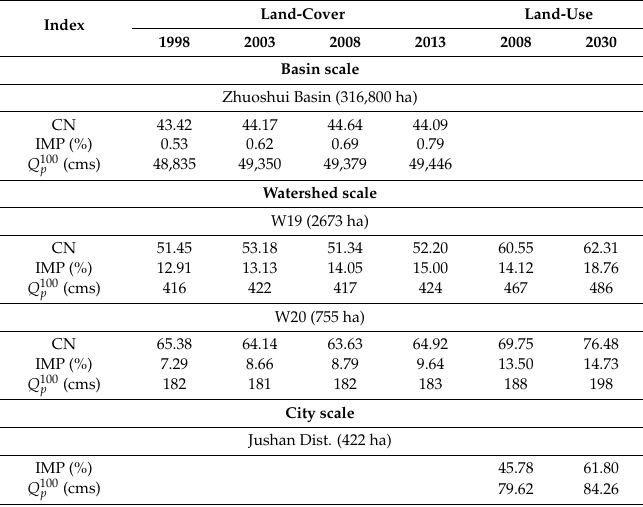
Table 8. Variations of CN, IMP, and Q 100 p related to land-cover and land-use changes on different study scales.